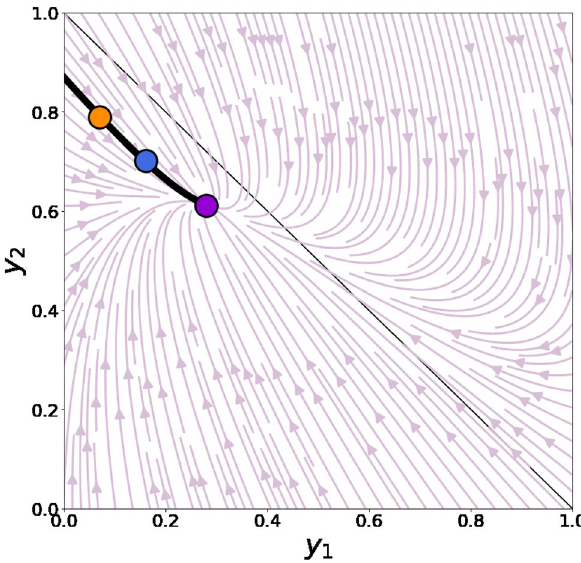
Figure 1. The phase portrait for system (1) calibrated with transition matrix (3). The violet circle marks the equilibrium point. The straight black solid line plots y 1 + y 2 = 1 . We are interested in the area y 1 + y 2 ≤ 1 beneath this line. The phase portrait of the system demonstrates that the equilibrium point is an asymptotically stable nodal sink that attracts the system regardless of its initial point. The blue and orange circles lying on the same phase curve (bold black line) represent opinion distributions y 1 = 0.161, y 2 = 0.702, y 3 = 0.137 (see Table 1 in the following subsection) and y 1 = 0.08, y 2 = 0.78, y 3 = 0.14 (see (6) in subsection Matching simulations and empirics)